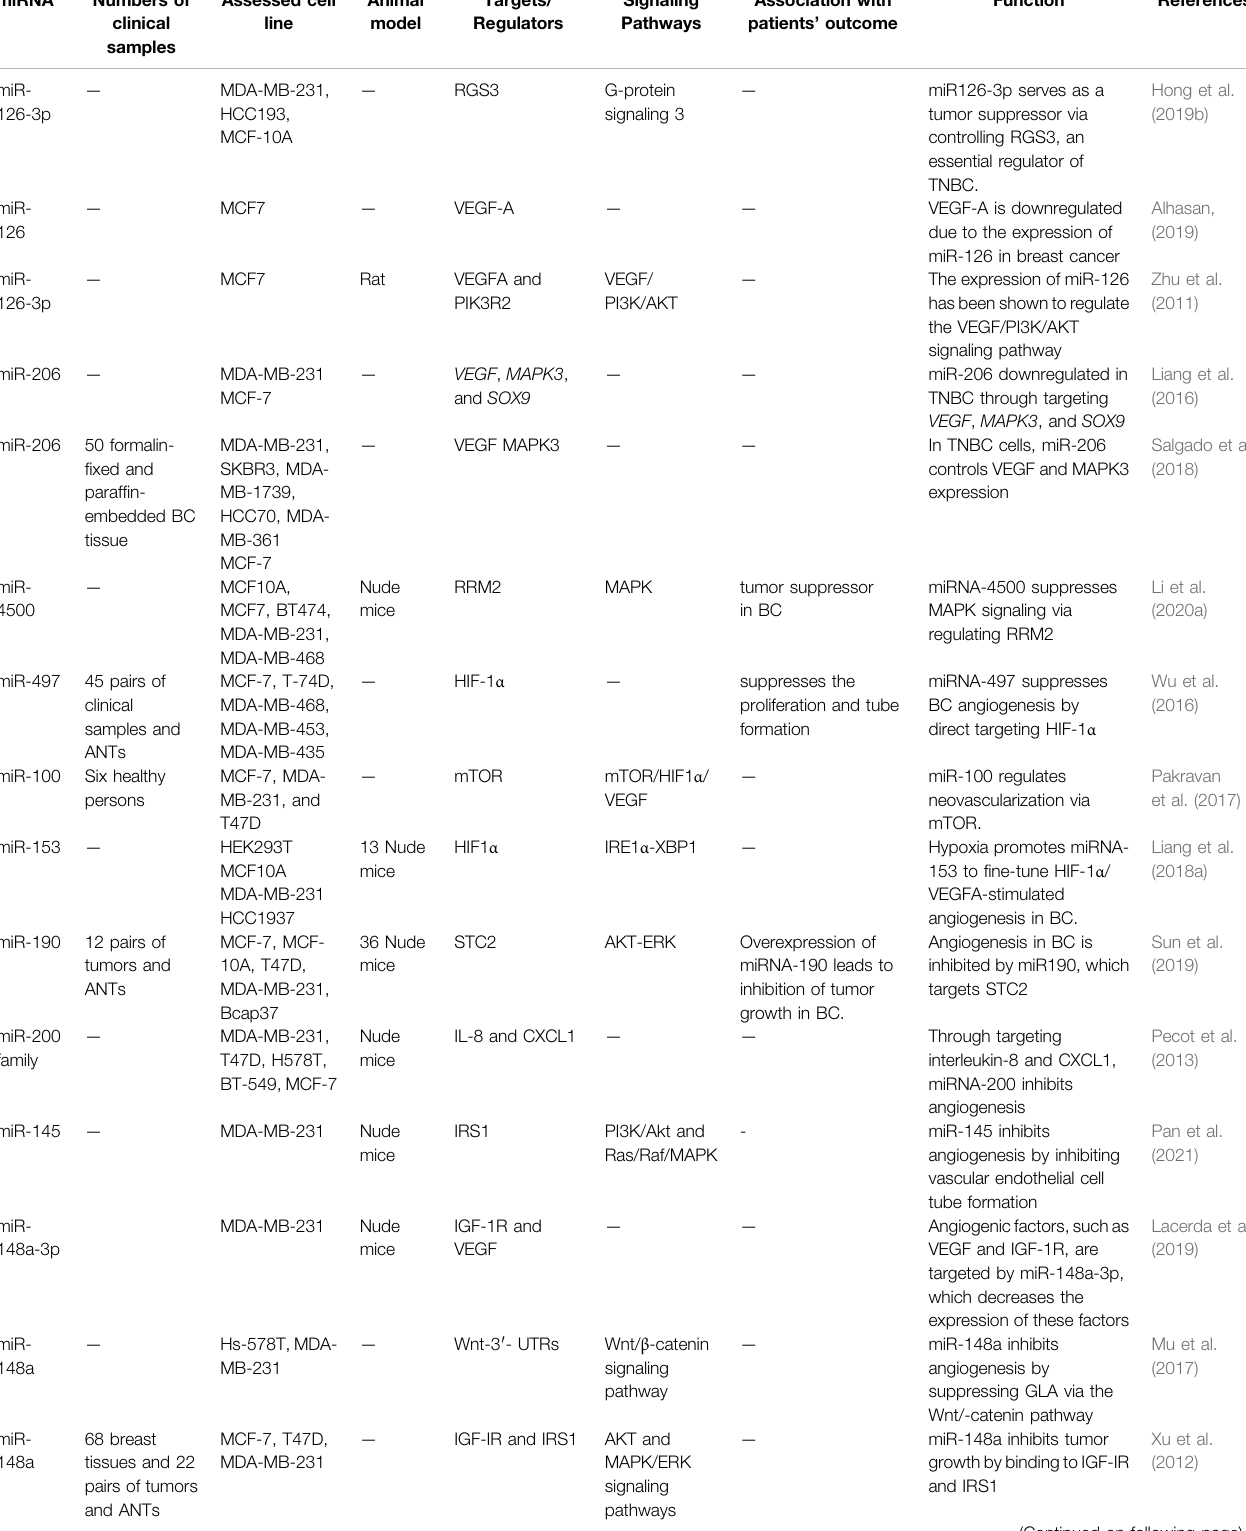
TABLE 1 | miRNAs that inhibit angiogenesis in Breast cancer (ANTs: adjacent non-cancerous tissues).